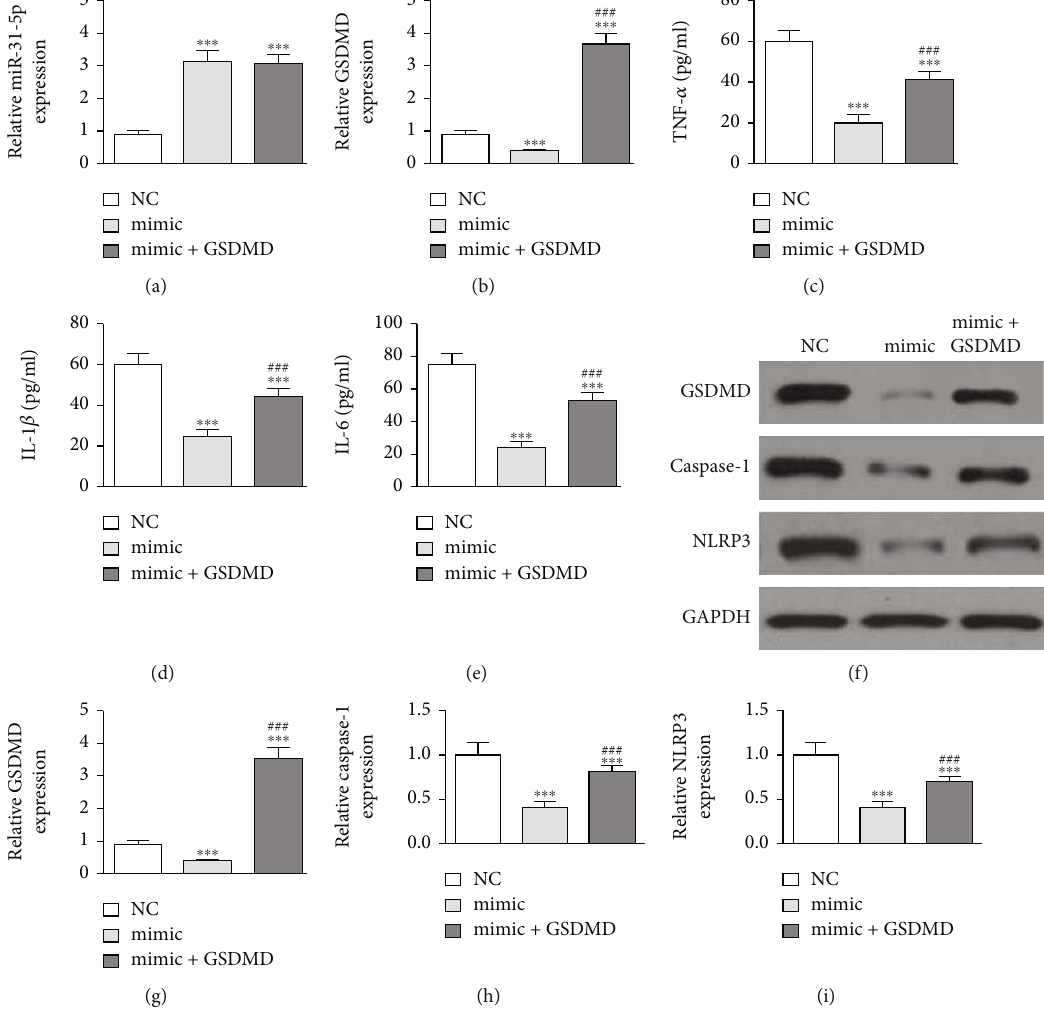
Figure 4: Upregulation of GSDMD reversed the protective e ff ect of miR-31-5p on LPS-induced in fl ammatory pyroptosis in RAW264.7 cells. (a, b) RT-qPCR detection showed the expression of miR-31-5p and GSDMD. (c) – (e) ELISA detection showed the expression of in fl ammatory factors TNF- α , IL-1 β , and IL-6 under LPS pretreatment (1 μ g/mL). Data were presented as mean ± SD . ∗∗∗ P < 0 : 001 , versus sham NC. ### P < 0 : 001 , versus mimic. (f) – (i) Western blot detection showed the expression of GSDMD, caspase-1, and NLRP3 expression. Data were presented as mean ± SD . ∗∗∗ P < 0 : 001 , versus sham NC. ### P < 0 : 001 , versus